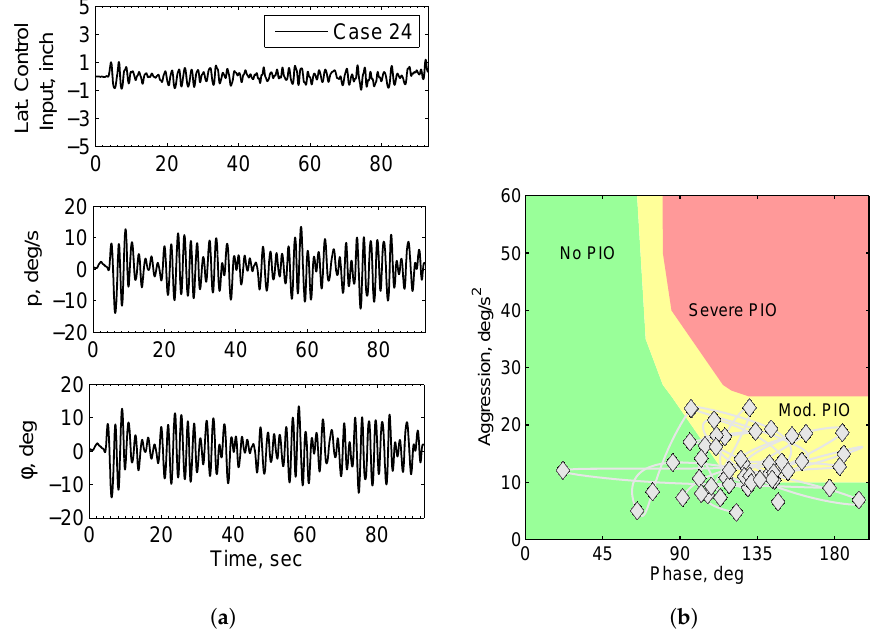
Figure 9. Case 24-lateral axis-APC = 5D, ( a ) time recording; ( b ) PAC results.